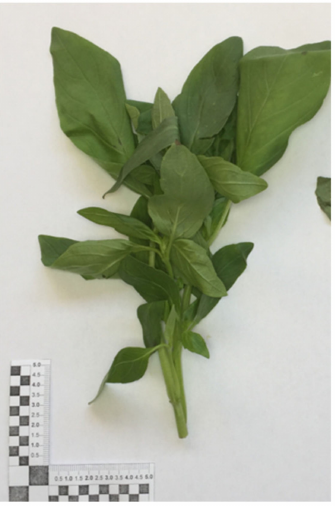
Figure 1. The fresh sample of Ocimum basilicum